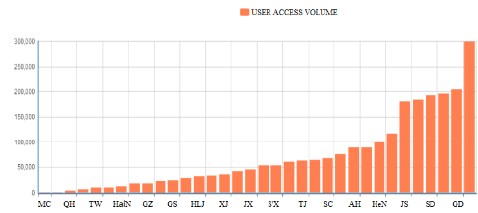
Figure 1. Provincial distribution of user access volume